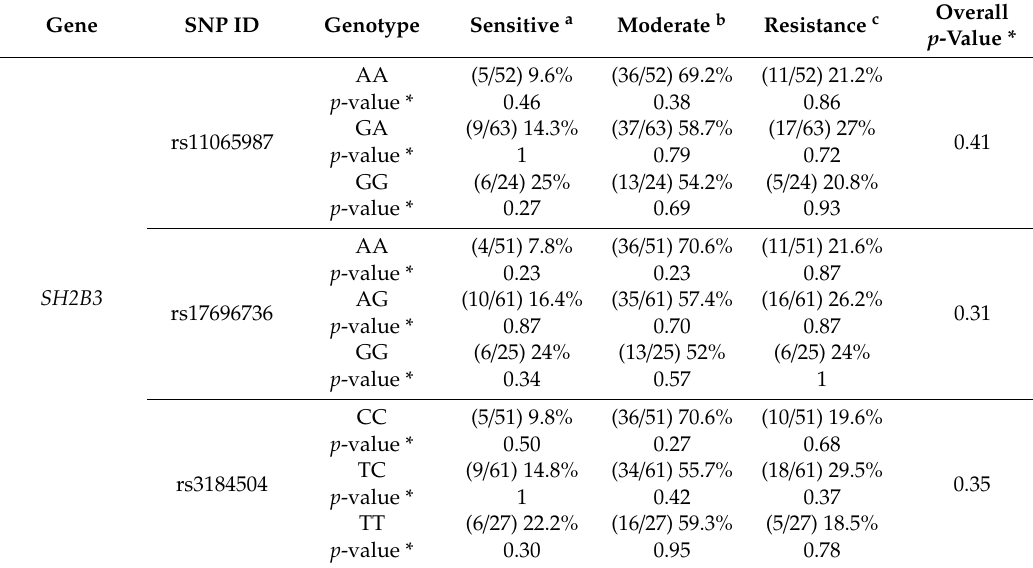
Table 3. Association of SH2B3 and MTHFD1L SNPs with warfarin sensitivity during the stabilization phase of therapy of 139 cardiovascular patients treated with